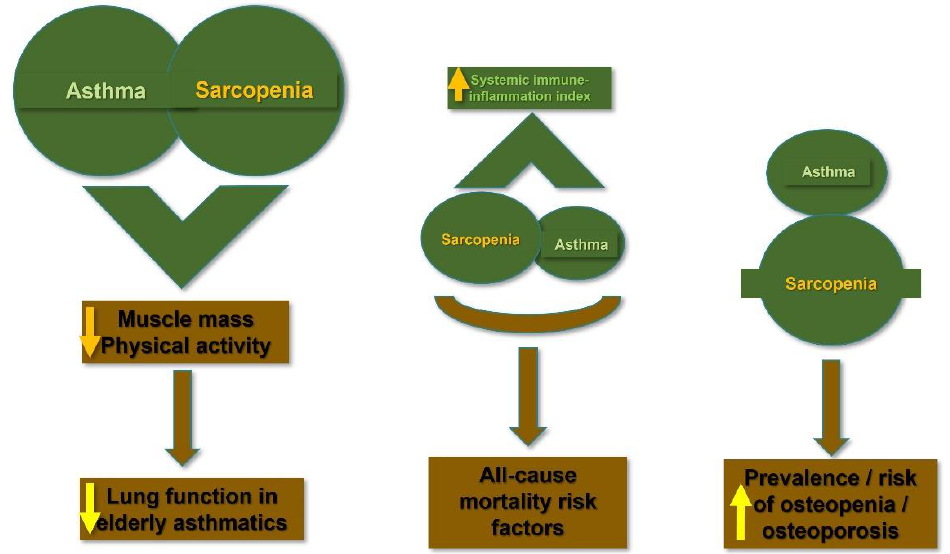
Figure 1. The relationship between bronchial asthma and sarcopenia.